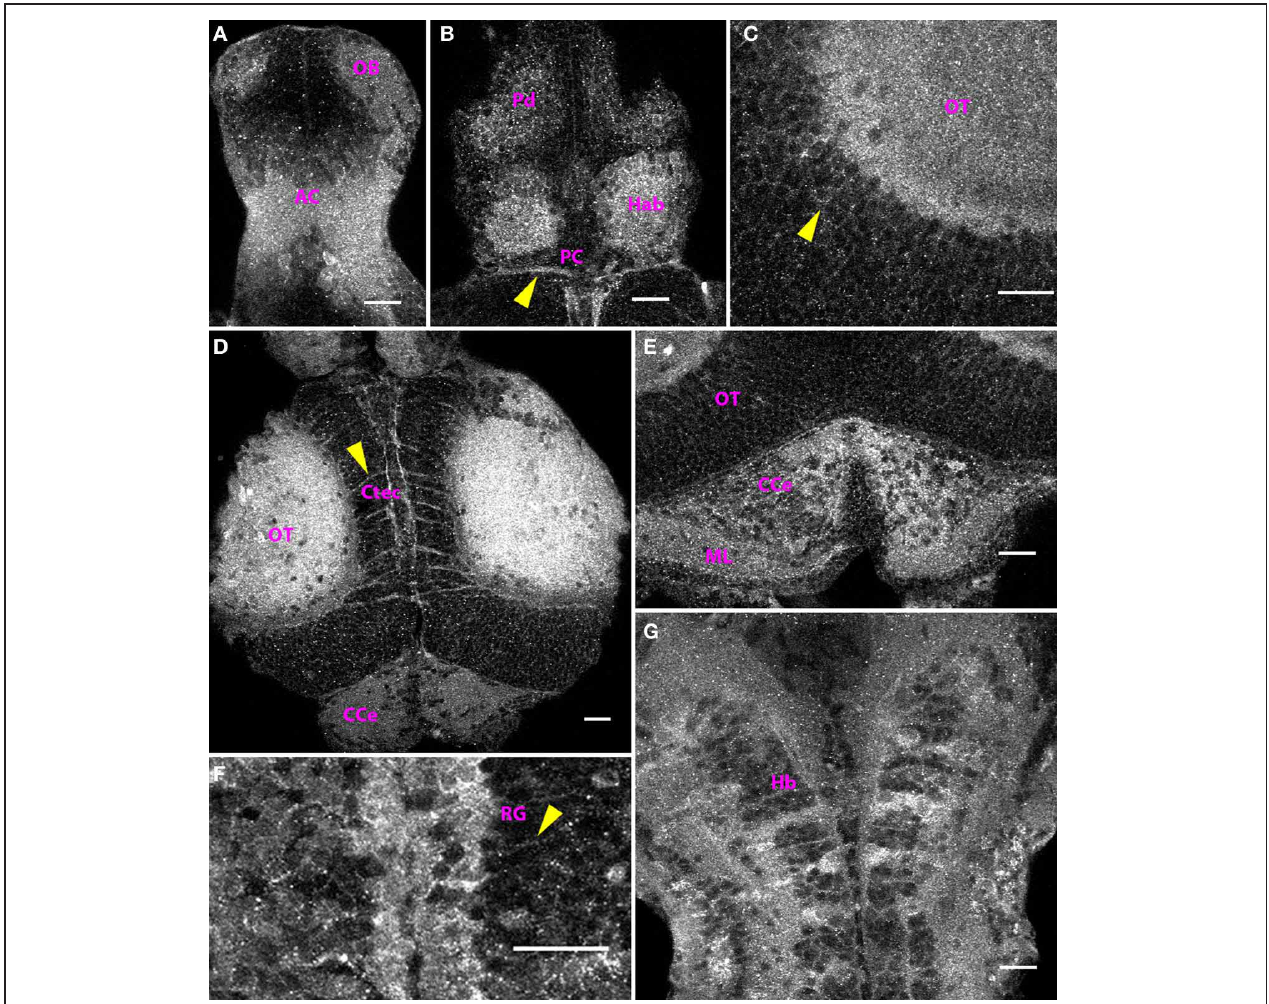
area. Faint labeling in cell bodies is also seen (arrowhead). (D) Cx35 staining in the mesencephalon showing intense staining in the optic tectal lobes in the neuropil area as well as in intertectal commissures (Ctec; arrowhead). The corpus cerebelli (CCe) can also be seen. (E) Cerebellar staining showing punctate pattern within the corpus cerebelli (CCe) and the molecular layer (ML). (F) Strong staining present in radial glia (RG) lining the rhombencephalic ventricle. Arrowhead marks the process from one glial cell coursing laterally. (G) Ladder-like staining pattern in ventral hindbrain (Hb). Scale bar for all panels: 20 µ